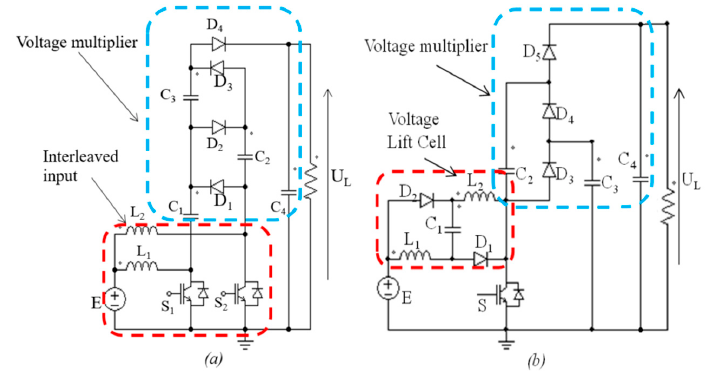
Figure 2. The converter with voltage multiplier and interleaved input ( a ), voltage lift cell (VLC) input ( b